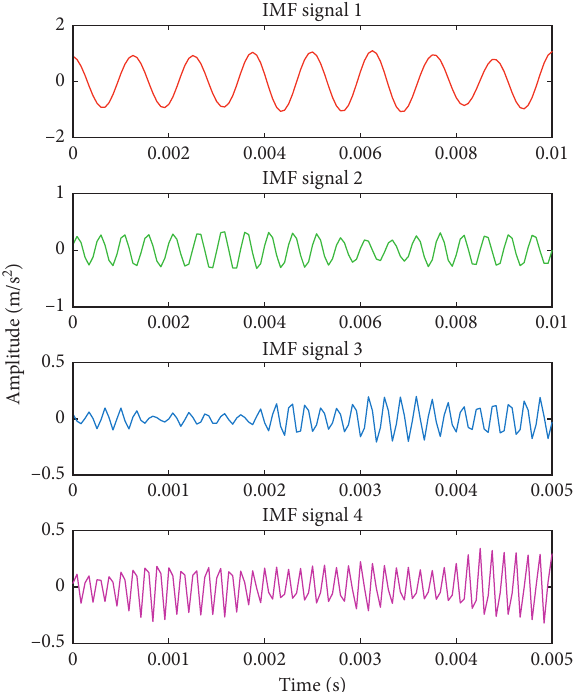
Figure 3: Time-domain waveforms of IMF decomposed with the VMD.